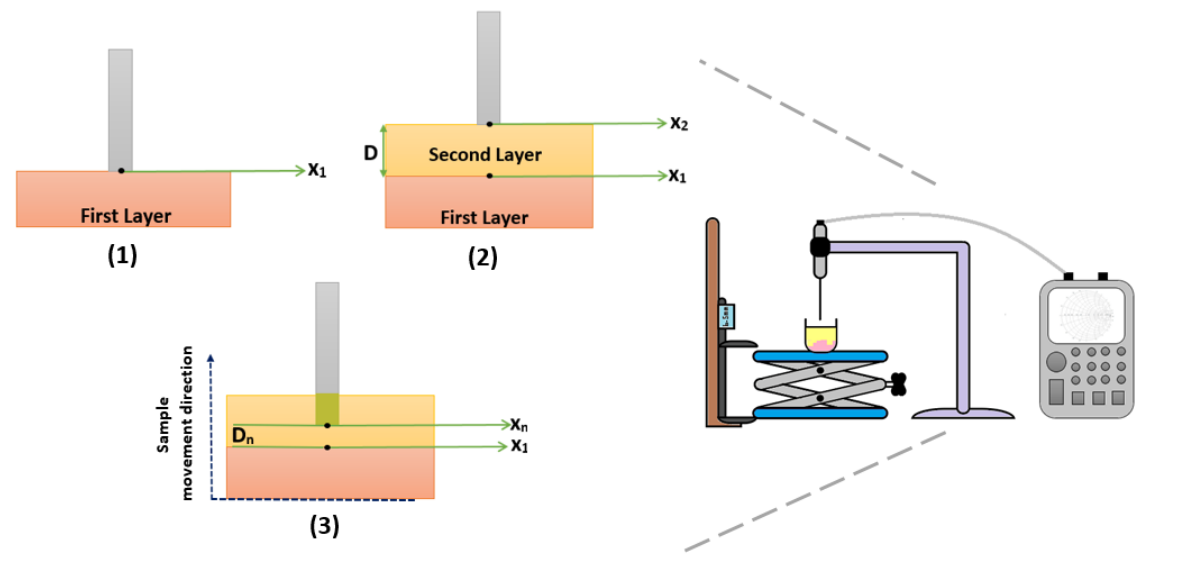
Figure 8. Measurement protocol for analyzing sensing depth with double-layered sample configuration. (1) X 1 position was determined based on the thickness of the first layer. (2) X 2 position was determined based on the probe tip distance from the first layer (D) was calculated (X 2 − X 1 ). (3) Double-layered sample configuration was gradually moved up to analyze the dielectric property change and sensing depth of the